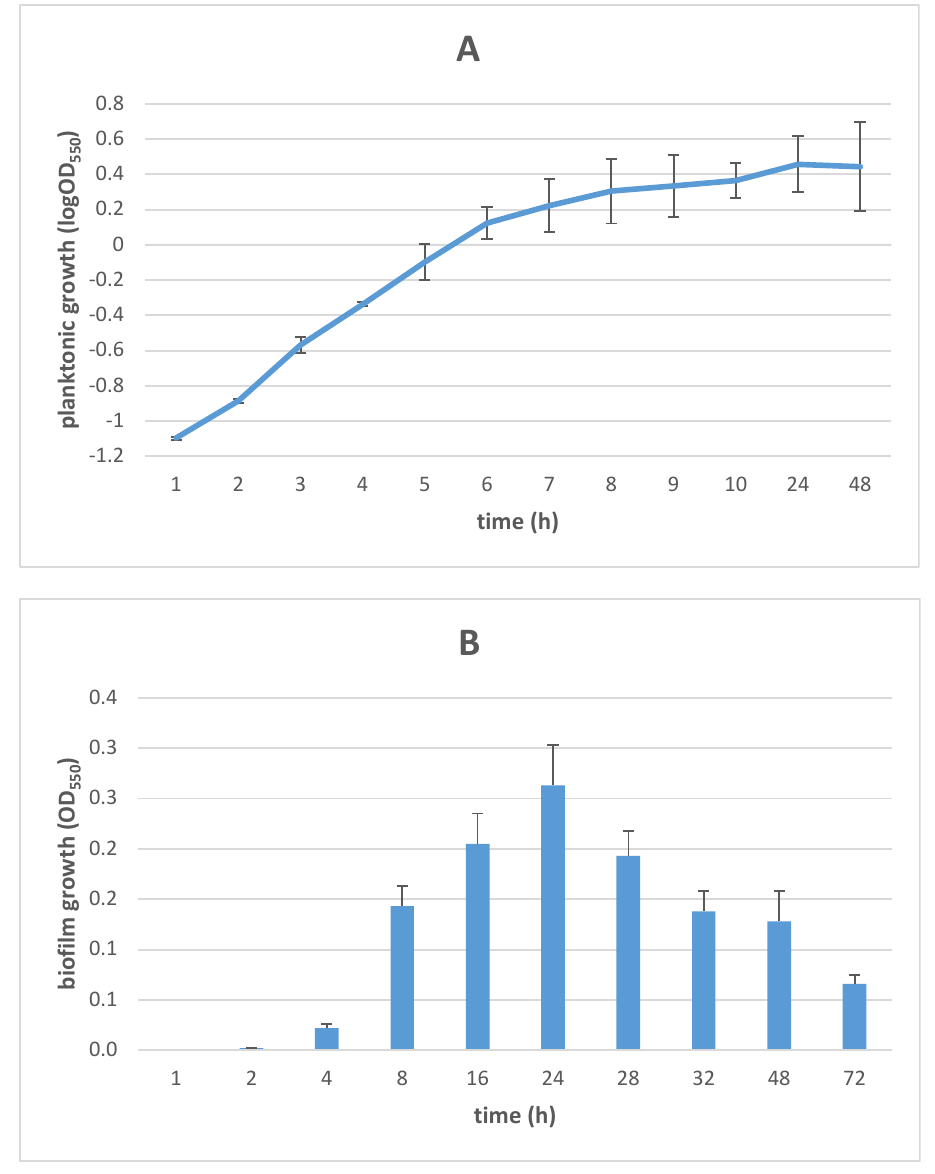
Figure 1. Growth kinetics of planktonic and biofilm S. maltophilia Sm126 cells. ( A ) Planktonic kinetics was measured in Trypticase Soy broth, under dynamic conditions, and results are shown as the log of mean OD 550 ± SD values (n = 6). ( B ) Biofilm formation kinetics was measured in a 96-well polystyrene microplate using a crystal violet-based colorimetric assay, and results are shown as mean OD 550 + SD values (n = 6).